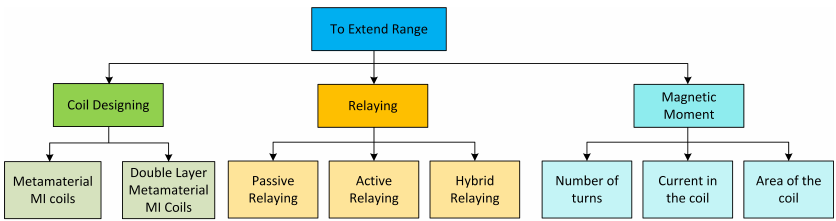
Figure 1. Various techniques that can be applied to extend the communication